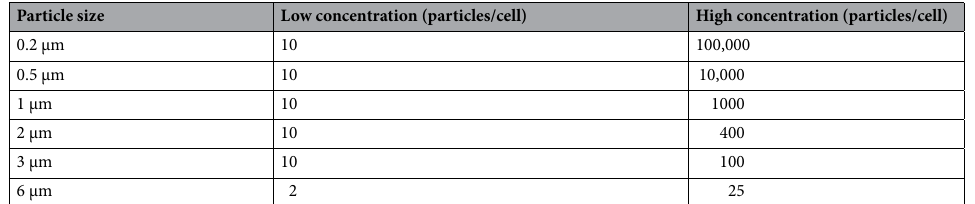
Table 2. Overview of MPP concentrations used for proliferation tests, flow cytometry, and ROS assays. For all particle sizes, a low and high concentration, depending on the particle size, was applied. Low concentration = < 1% coverage of the plate; medium concentration = 1–10% coverage of the plate; high concentration = 20–30% coverage of the